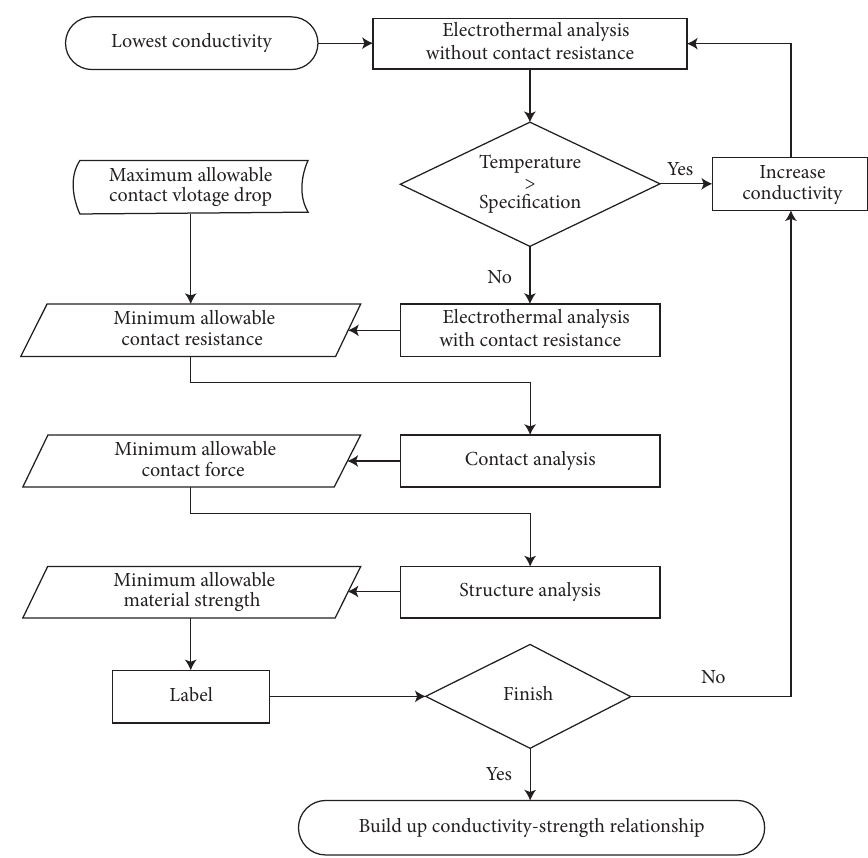
Figure 3: The analysis sequence for establishing the material selection